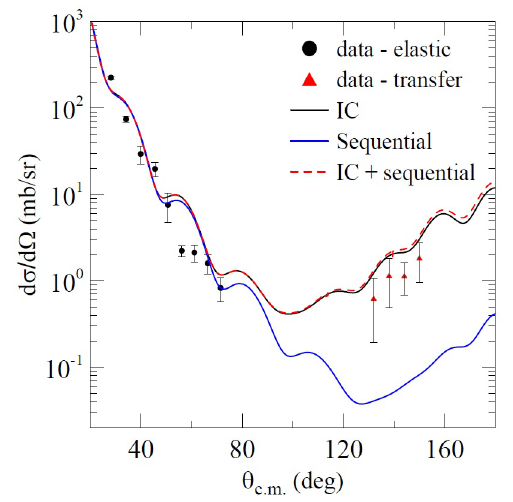
Fig. 4 . Comparison of the experimental data and theoretical predictions corresponding to the elastic scattering and elastic- transfer angular distributions in the 7 Be+ 9 Be collision at 23.1